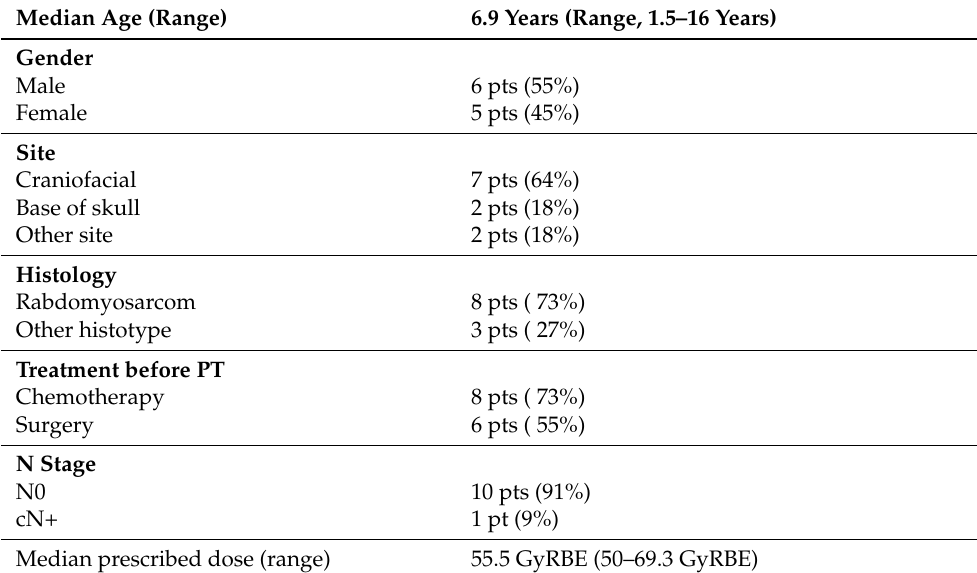
Table 2. Patient and tumor characteristics. ‘Pts’: patients, ‘PT’: proton